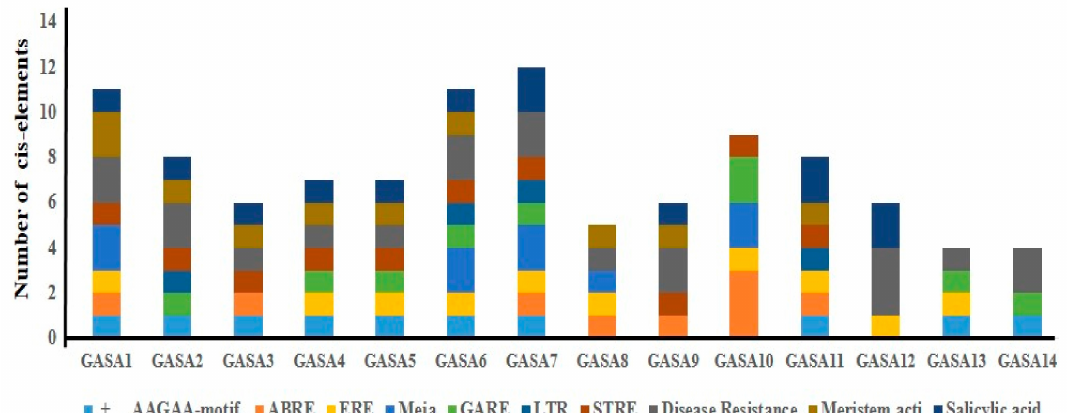
Figure 7. Cis -element prediction in the VvGASA